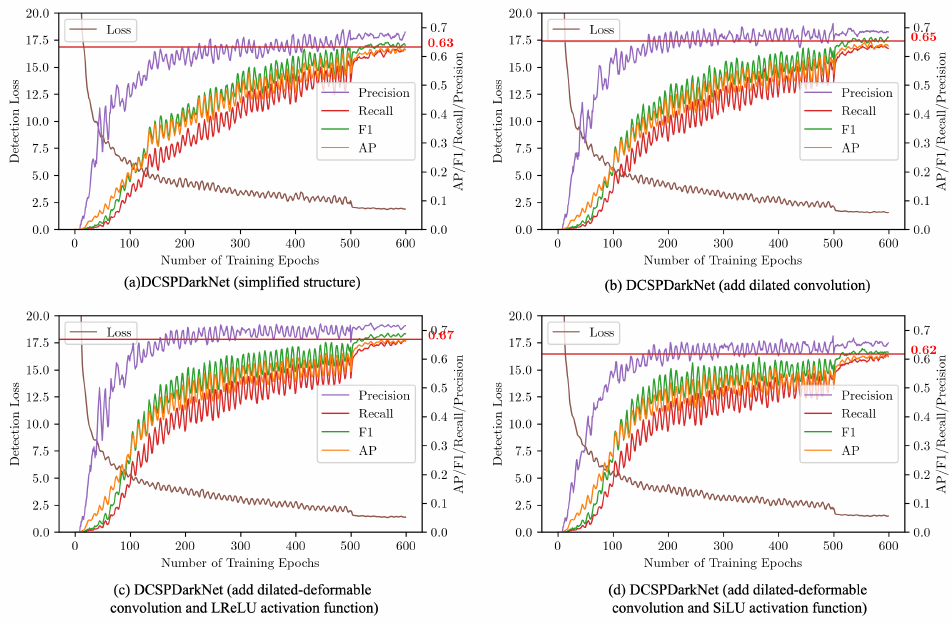
Figure 10. The training curve in the ablation experiment on the garbage data set: ( a ) the simplified model of the network; ( b ) the model after adding dilation convolution to ( a ); ( c ) the model after adding deformation convolution and the LReLU activation function to ( a ); and ( d ) the model after adding deformation convolution and the SiLU activation function to ( a